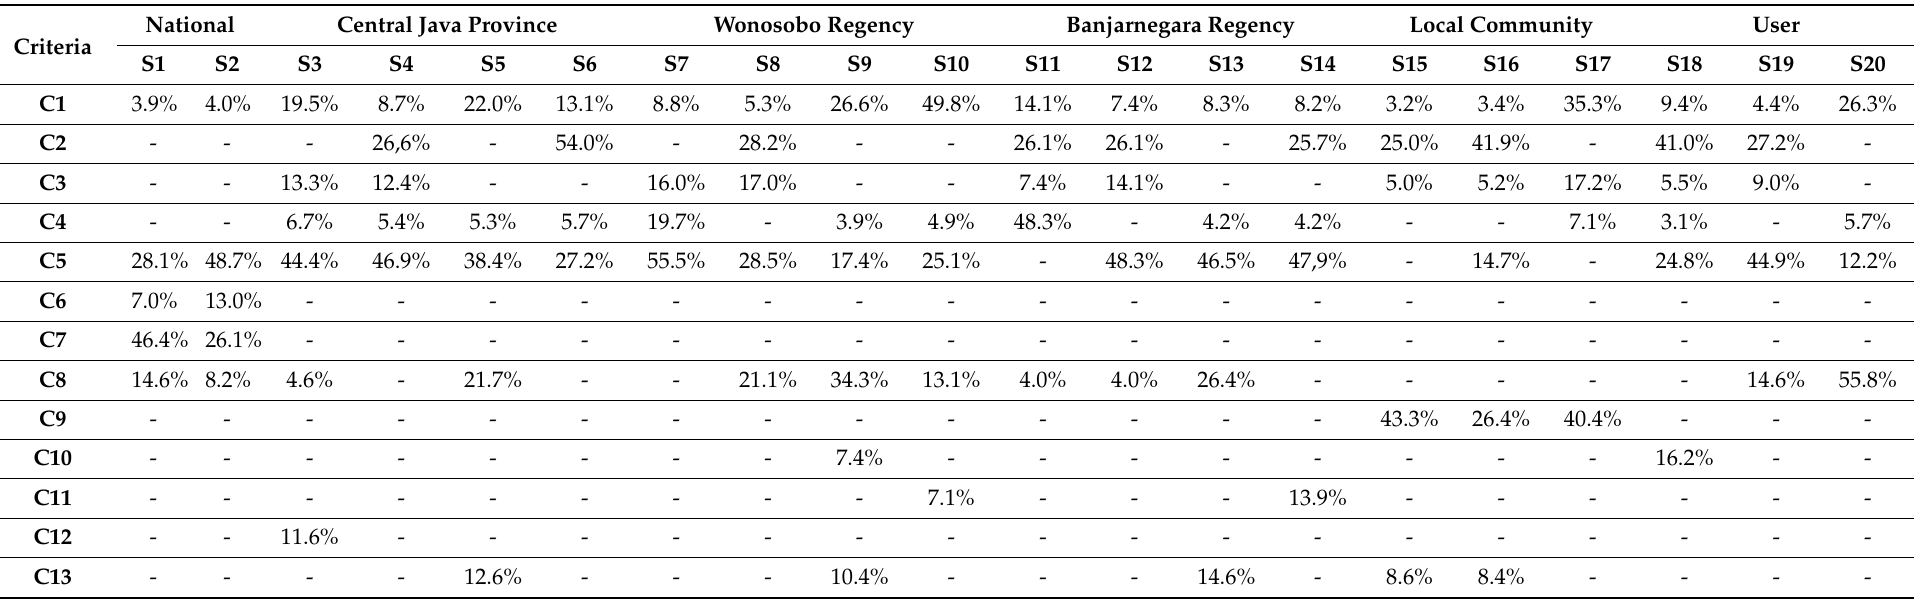
Table 3. Results of stakeholder selection and assessment of